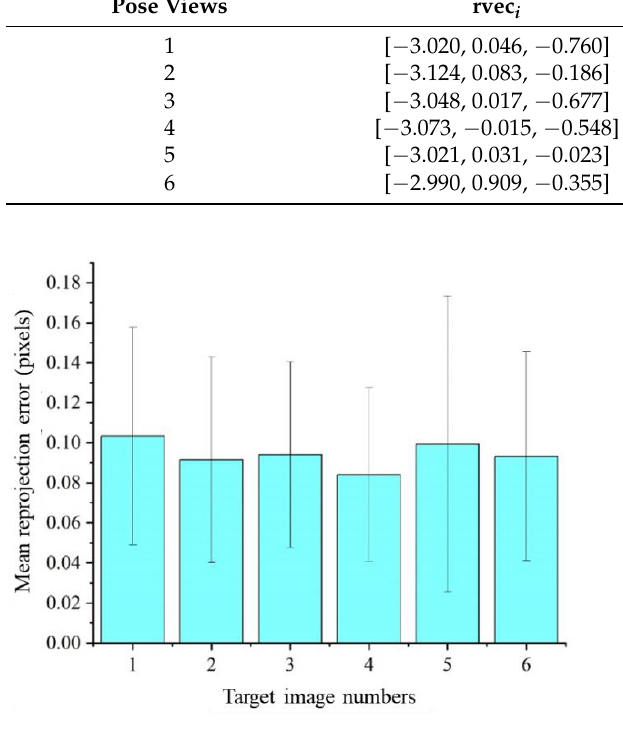
Table 4. The parameters of the light planes.